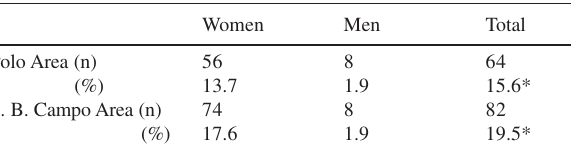
Table 2 - Prevalence of chronic autoimmune thyroiditis by gender in the two studied